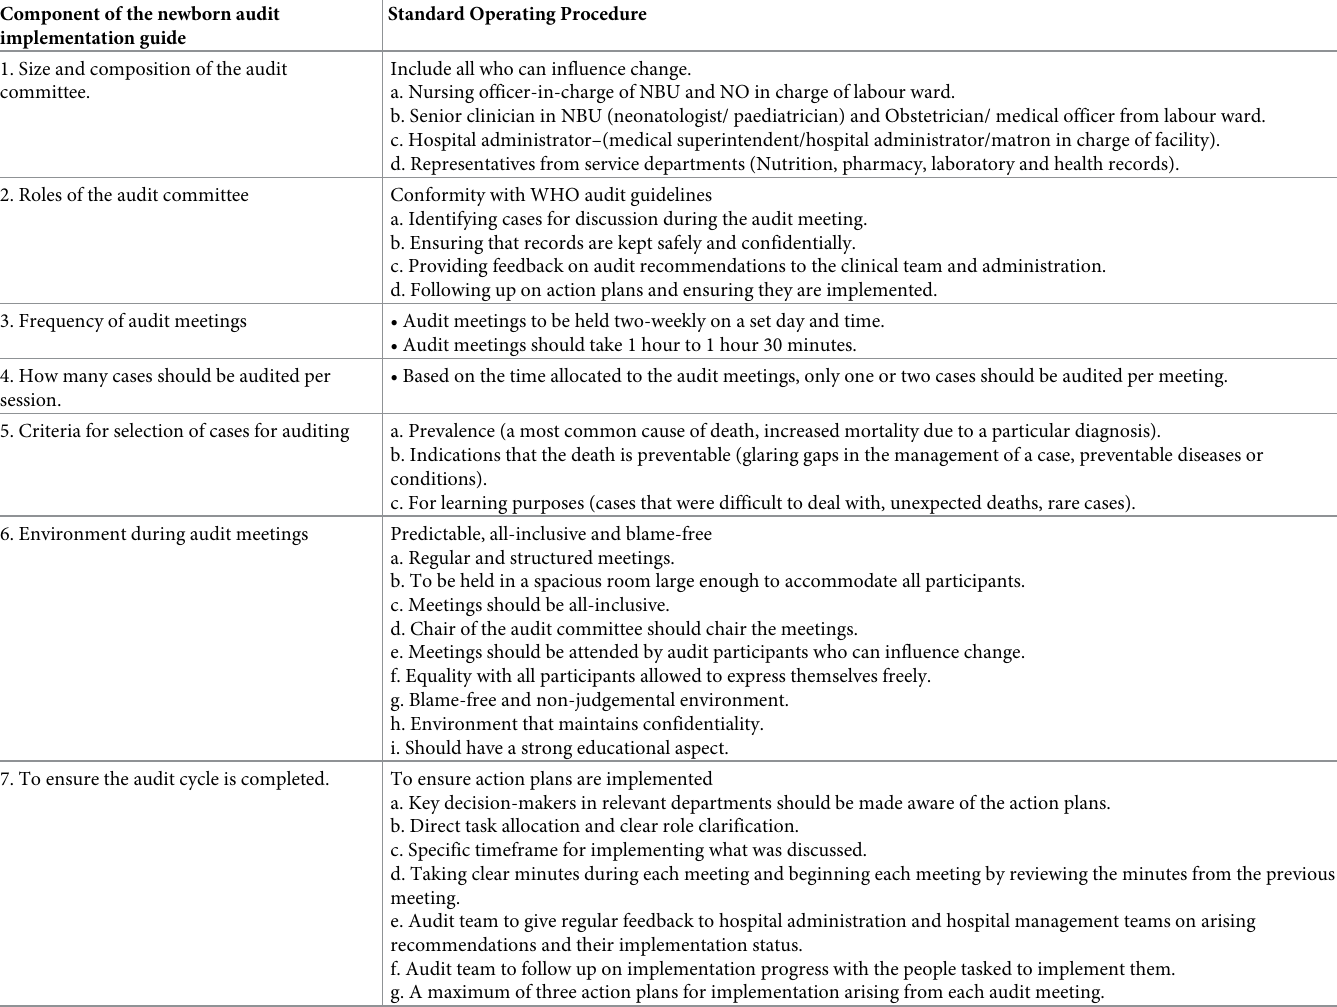
Table 2. Components of the audit implementation